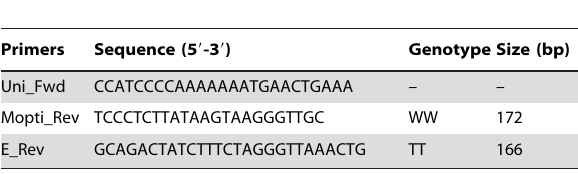
Table 1. Primer sequences and amplicon size (bp) for genotyping in cage-invasion